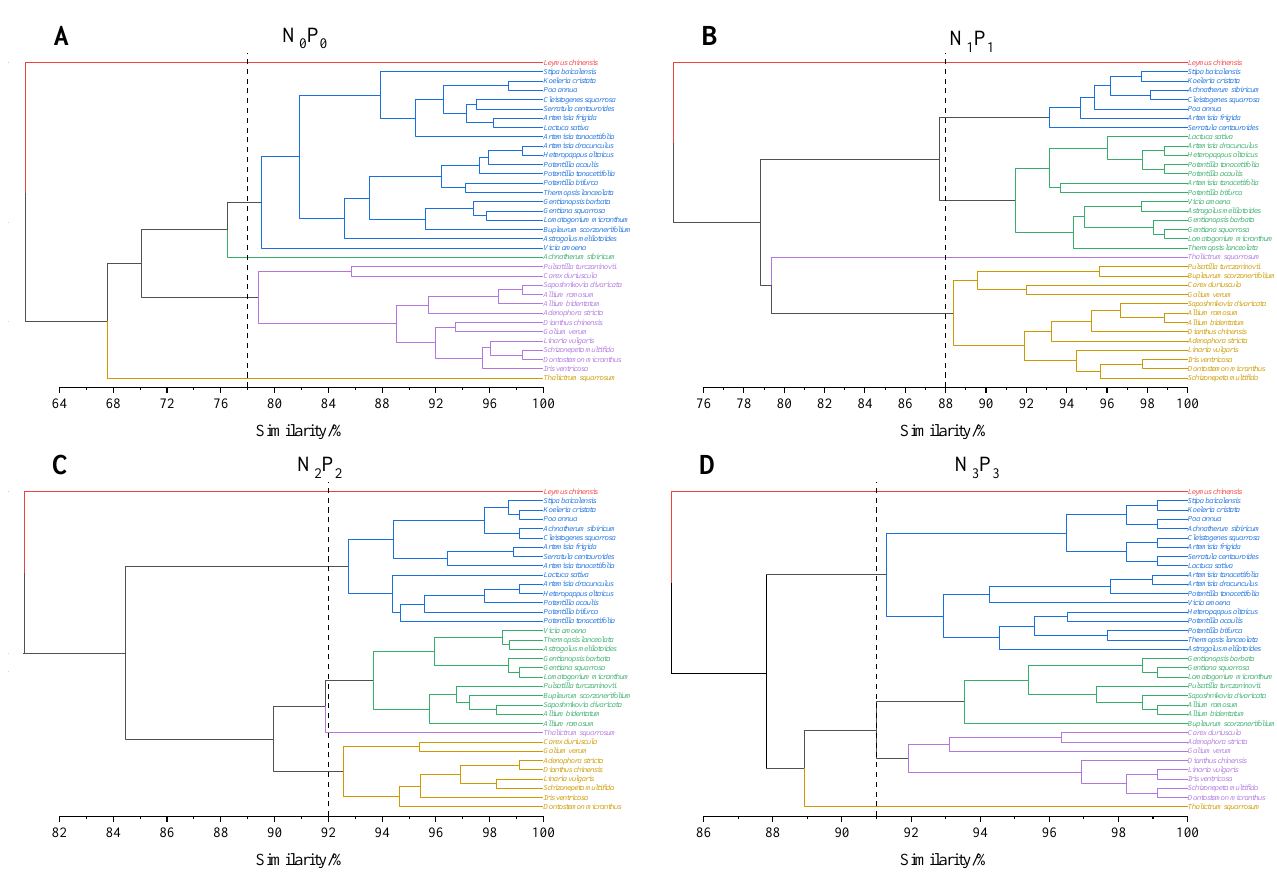
Figure 3. Clustered dendrograms of the plant community systems under different nitrogen and phosphorus addition treatments. ( A ) No NP addition (N 0 P 0 ), ( B ) low-level NP addition (N 1 P 1 ), ( C ) medium-level NP addition (N 2 P 2 ), and ( D ) high-level NP addition (N 3 P 3 ). The different colors indicate that the plant species have been divided into different subcommunities.